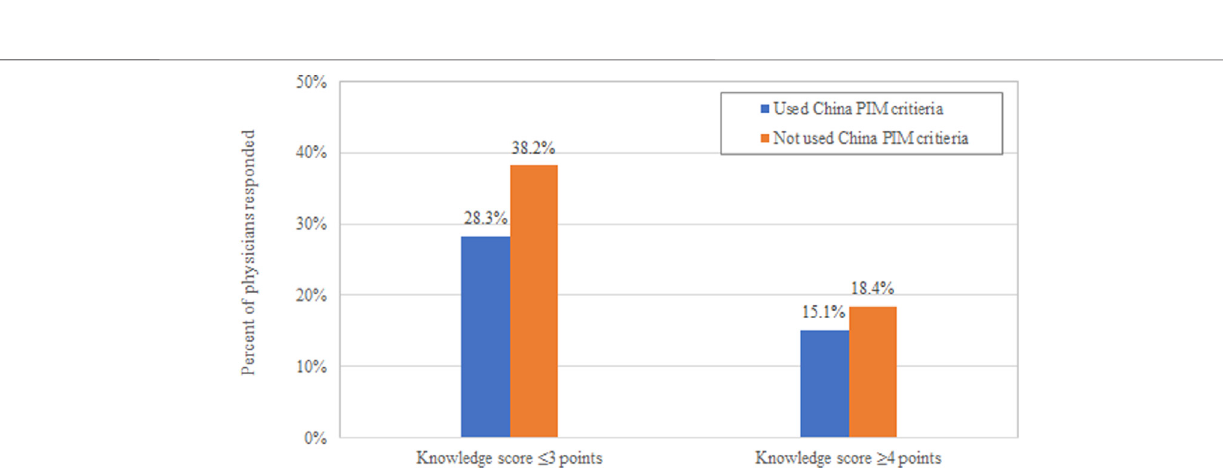
FIGURE 2 | Physician ’ s response to clinical vignettes.